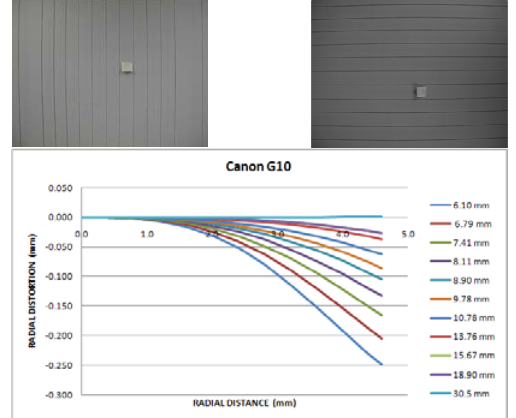
Figure 6. Calibration of Canon Powershot G10 zoom lens. Upper: two images of vertical and horizontal lines at 2 m distance with zoom position at 6.1 mm. Lower: Symmetrical radial distortion functions (averaged from repeated calibrations) for the whole range of zoom steps (from EXIF data) in the G10